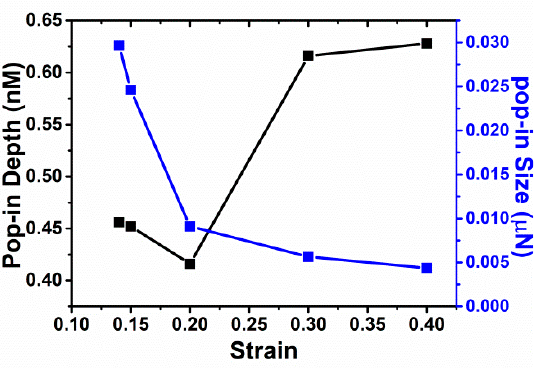
Figure 10. Pop-in depth and size vs. prestrain for Cu with plastic deformation, indented with tip radius R = 7.5 nm.